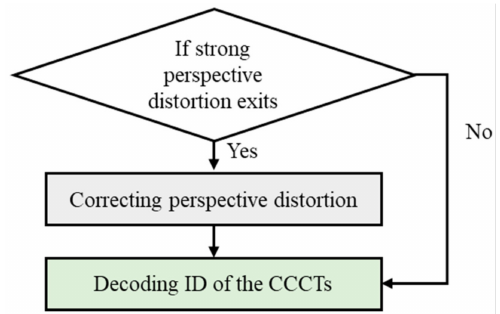
Figure 10. The workflow process to identify the number of